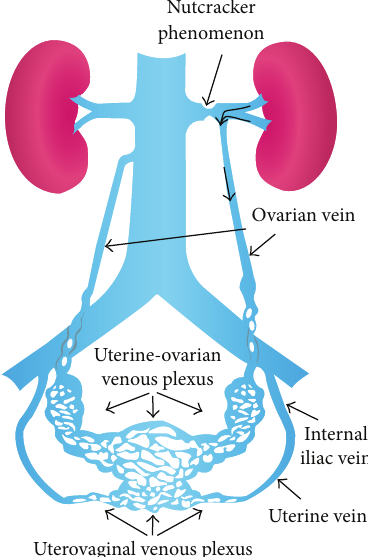
Figure3:Anatomicillustrationdemonstratingthekeyvenousanas- tomoses that facilitate shunting of renal blood when a nutcracker scenario arises. Image adapted with permission from Umeoka et al., Radiographics, 2004, 24 :197, RSNA